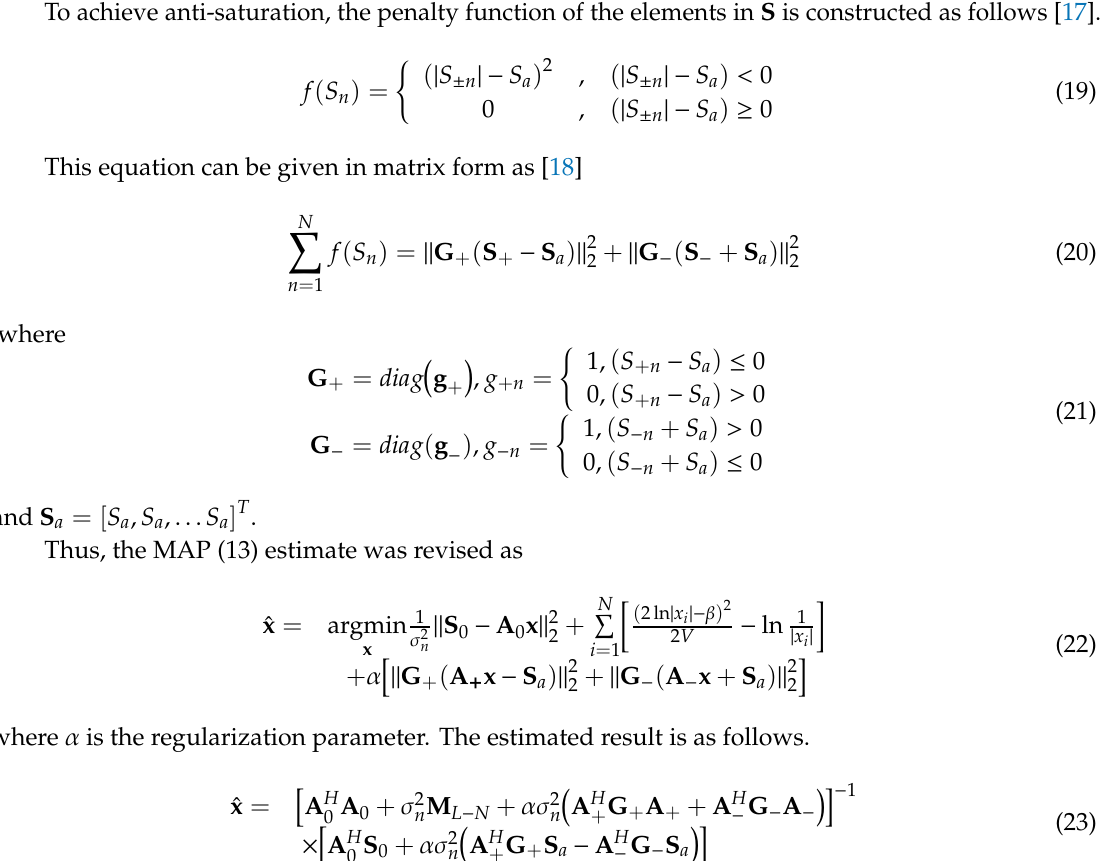
Figure 12. The separation of matrix A according to the saturation of signal S . All green rows were recombined into matrix A 0 , and the red and yellow ones were recombined into matrices A + and A − respectively.